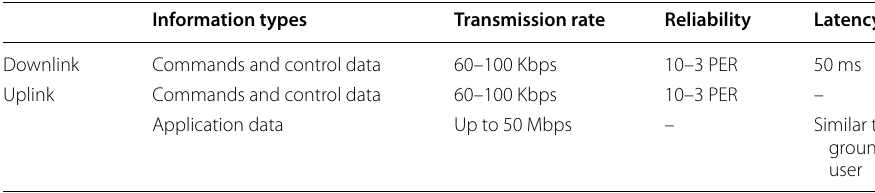
Table 1 The requirements for UAV communication [13] Information